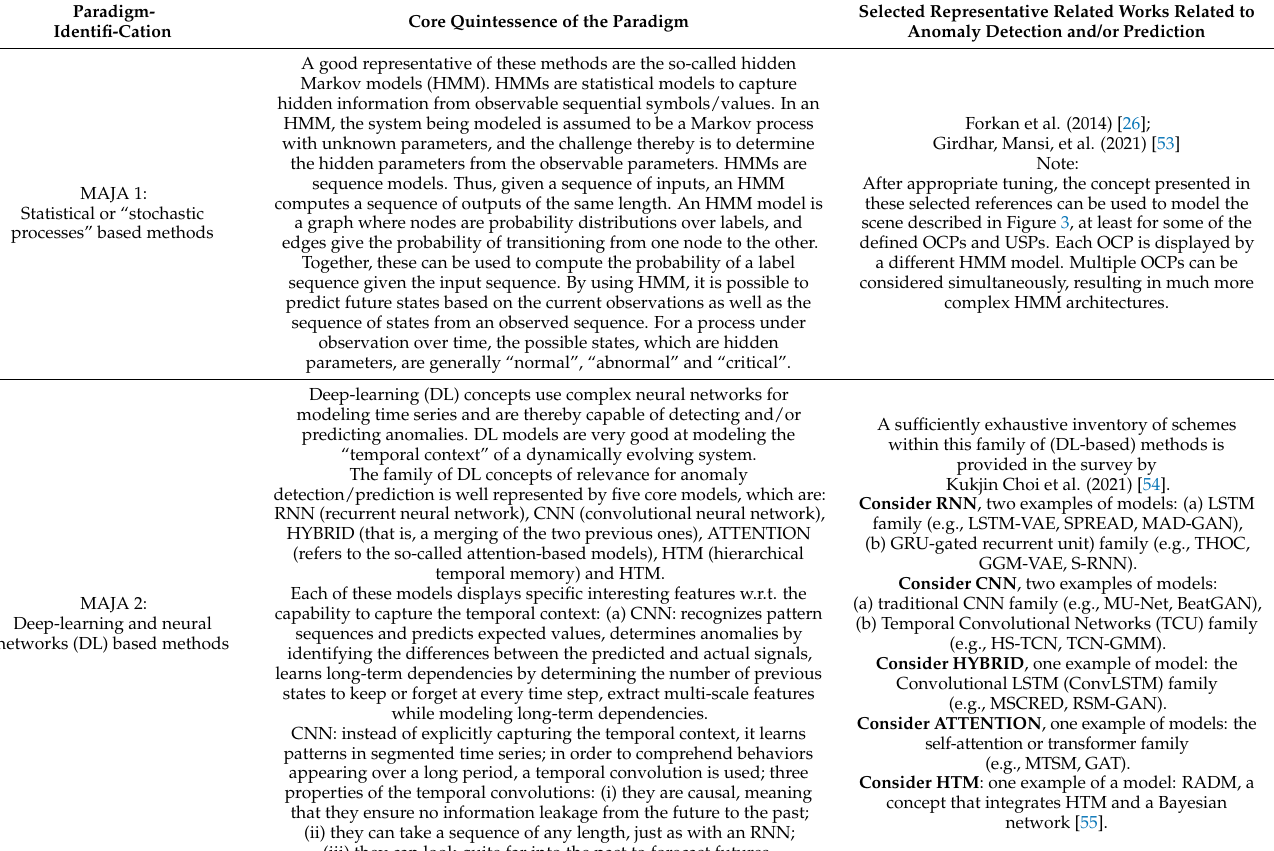
Table 7. A comprehensive overview of the four major approaches or paradigms for anomaly detection and/or forecasting, which are also an application for the target context of “monitoring the physical activity of a human in